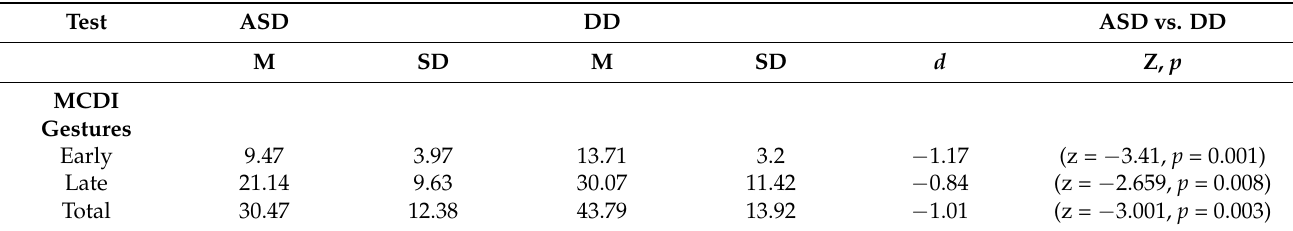
Table 7. Descriptive statistics corresponding to direct measures for early gestures, late gestures, and the total number for